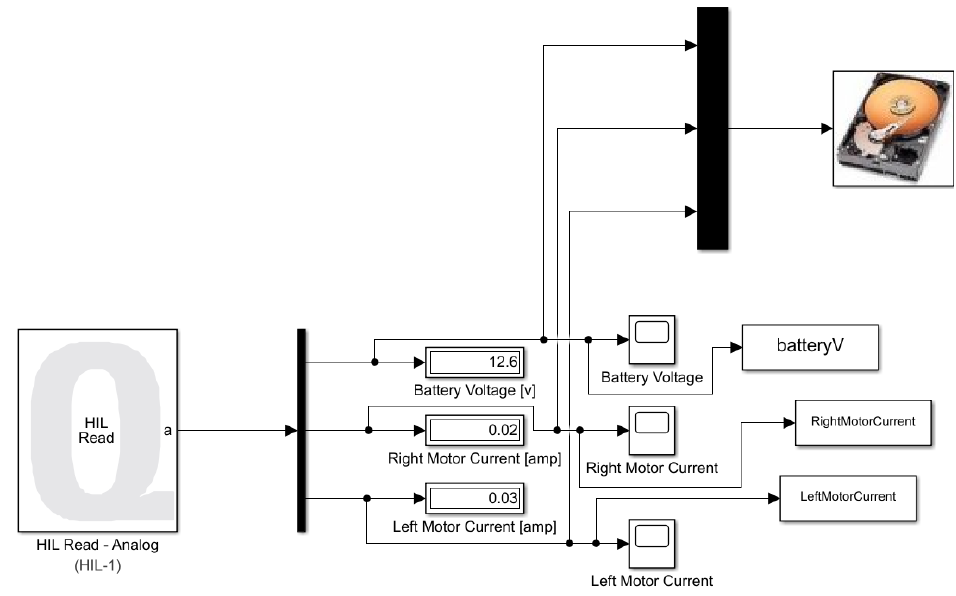
Figure 8. Simulink diagram for recording of the QBot 2e battery